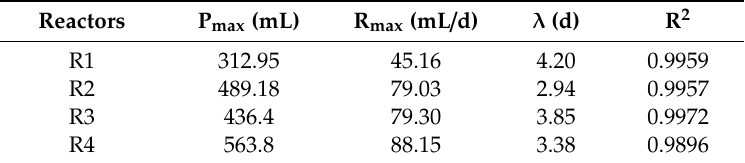
Table 2. Calculated results using modified Gompertz equation for biogas